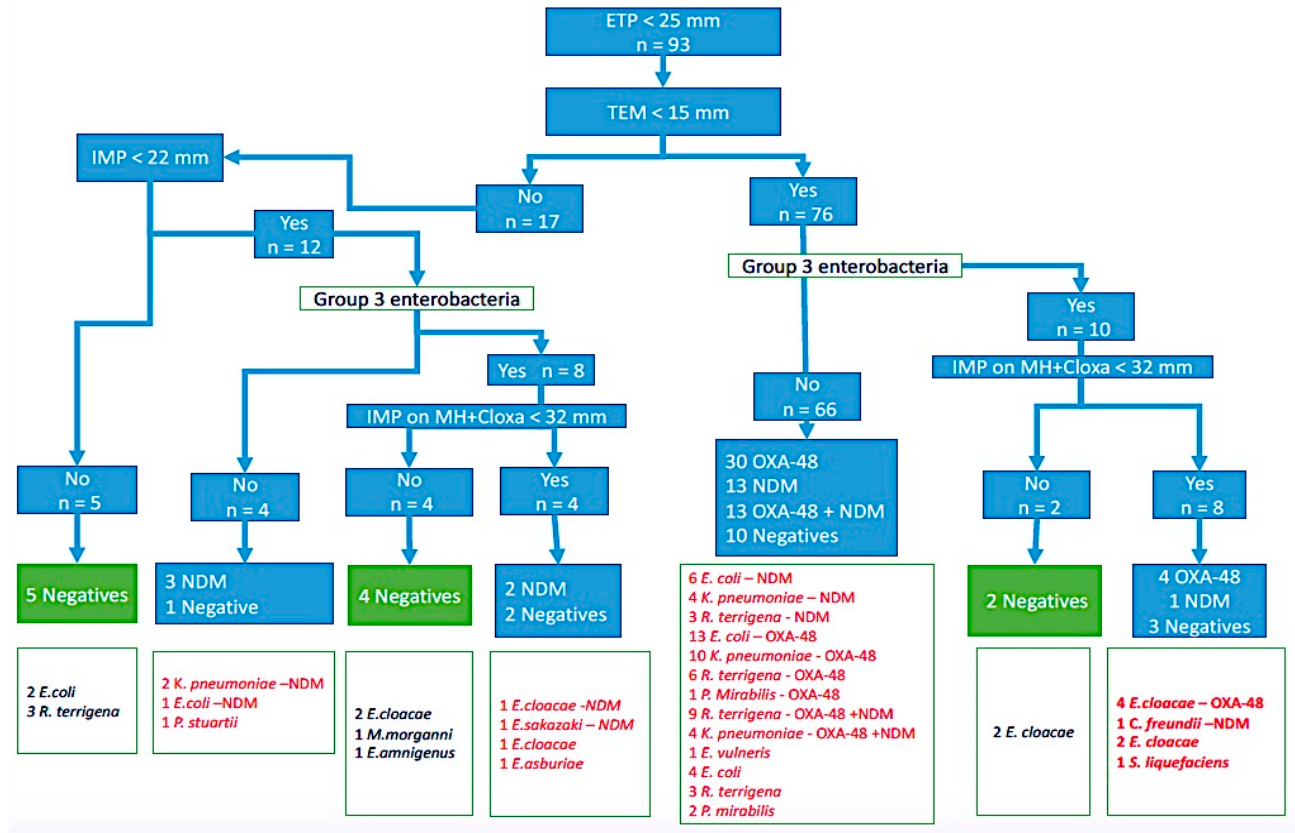
Figure 3. Comparison of IC test results with the EUCAST algorithm.